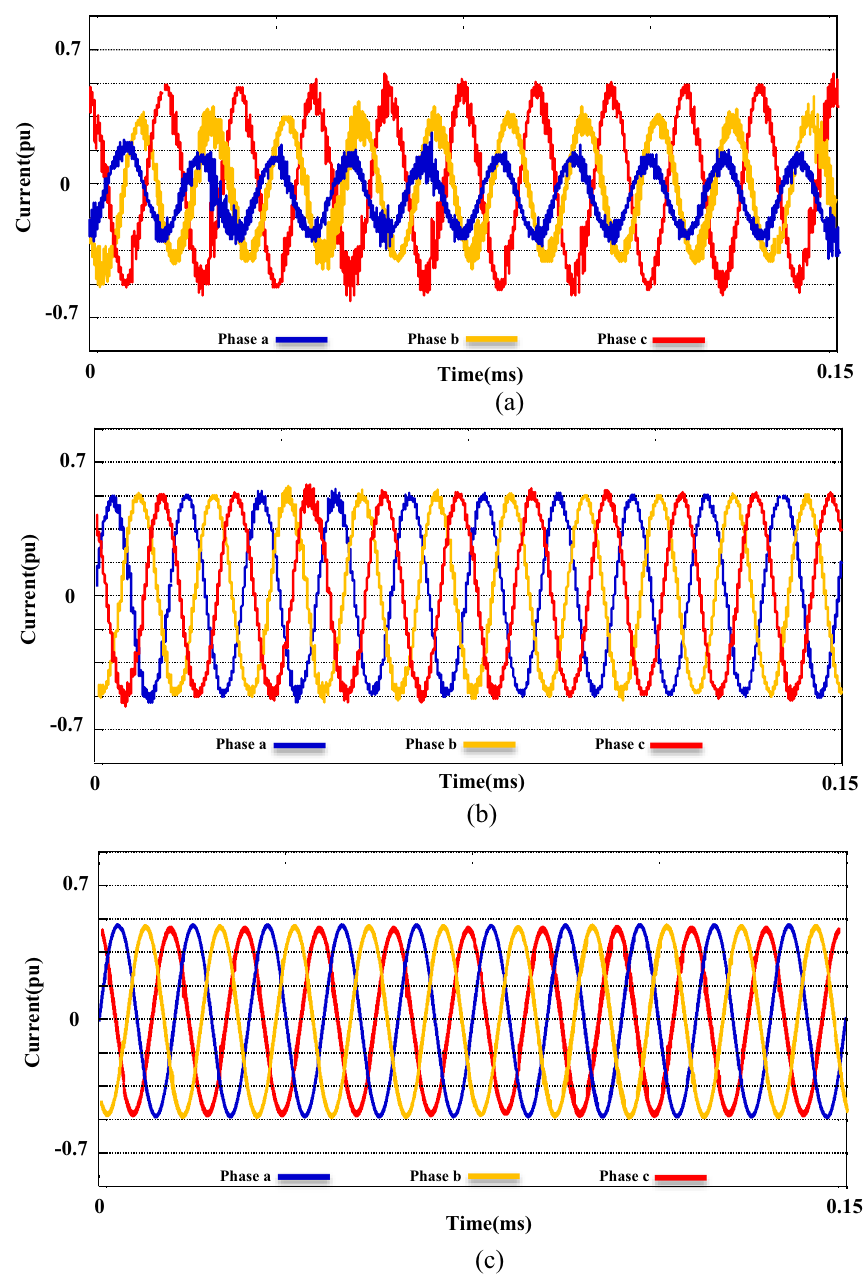
Figure 16. The current THD of the system: ( a ) Without compensator devices. ( b ) With the UPQC module. ( c ) With the M-UPQC